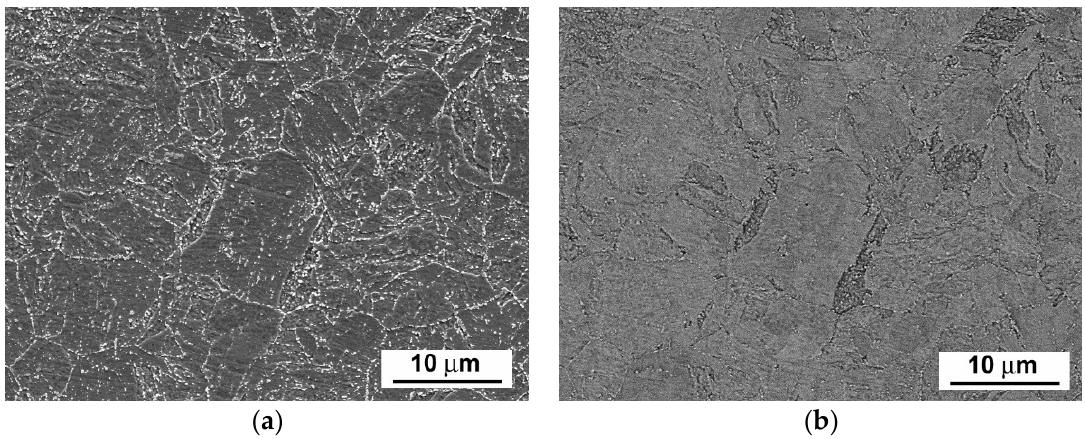
Figure 3. SEM images of investigated P92 steel in N&T material condition visualized by ( a ) secondary electrons and ( b ) back-scattered electrons.